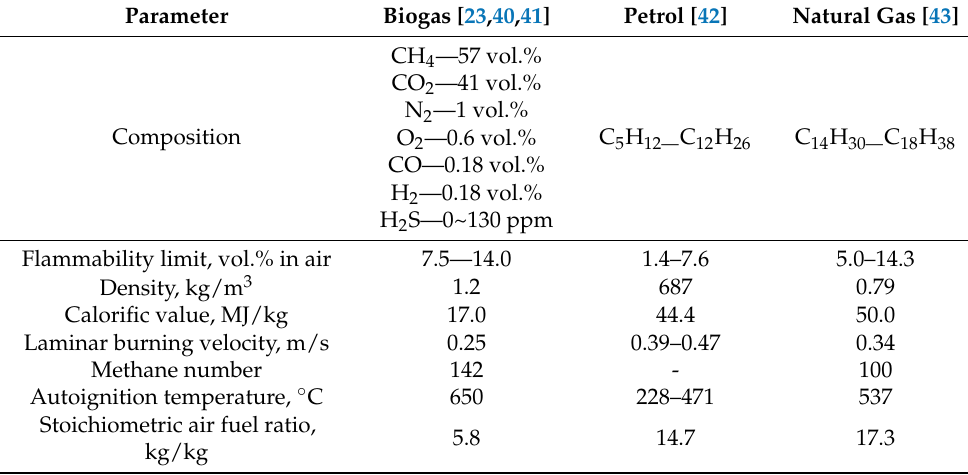
Table 4. Biogas properties